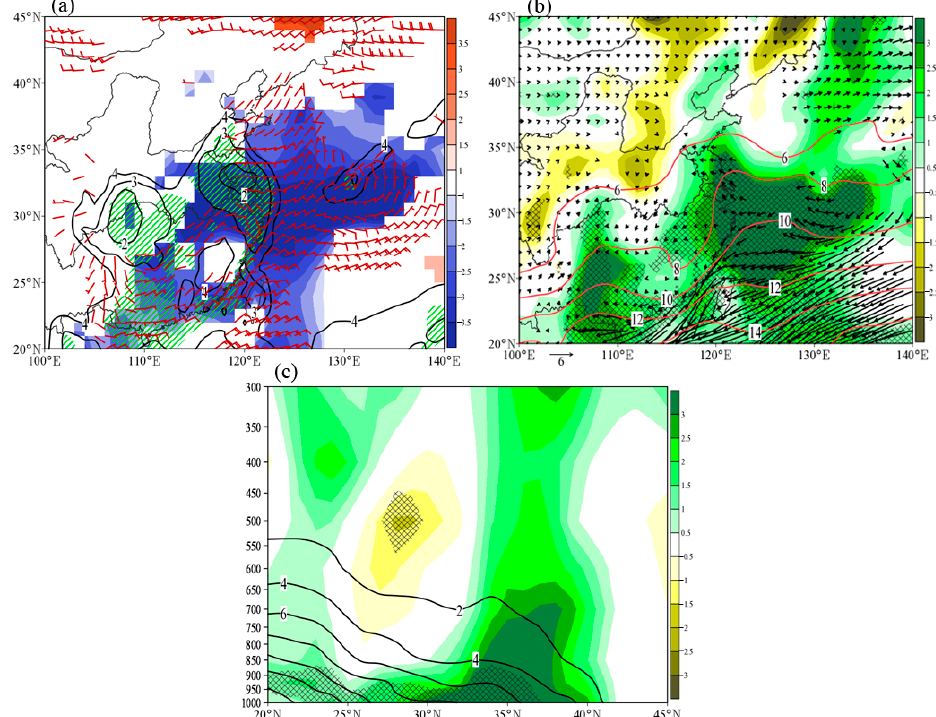
Figure 9. ( a ) The composite 10-m winds (only anomalies exceeding the 0.01 significance level are shown as shafts, units: m·s − 1 ), the standard deviation of 10 m wind velocity standard deviation of 10 m wind velocity (only anomalies exceeding the 0.01 significance level are shaded), and the 2 m dew point depression (contours are values less than 4 °C ) . The green oblique line area denotes the anomalies of 2-m dew point depression exceeding the 0.01 significance level. ( b ) The composite 1000 hPa specific humidity (contours are values more than 6g·kg − 1 ), 1000 hPa vapor flux (only anomalies exceeding the 0.01 significance level are shown as vectors, units: 10 − 2 g·kg − 1 ·m·s − 1 ), and standard deviation of specific humidity advection (shaded). The crossed area denotes anomalies of specific humidity advection exceeding the 0.01 significance level. ( c ) The vertical section of composite original specific humidity (contours are the values more than 2g·kg − 1 ) and standard deviation of specific humidity (shaded) across 120° E. The crossed area denotes anomalies of specific humidity exceeding the 0.01 significance level.